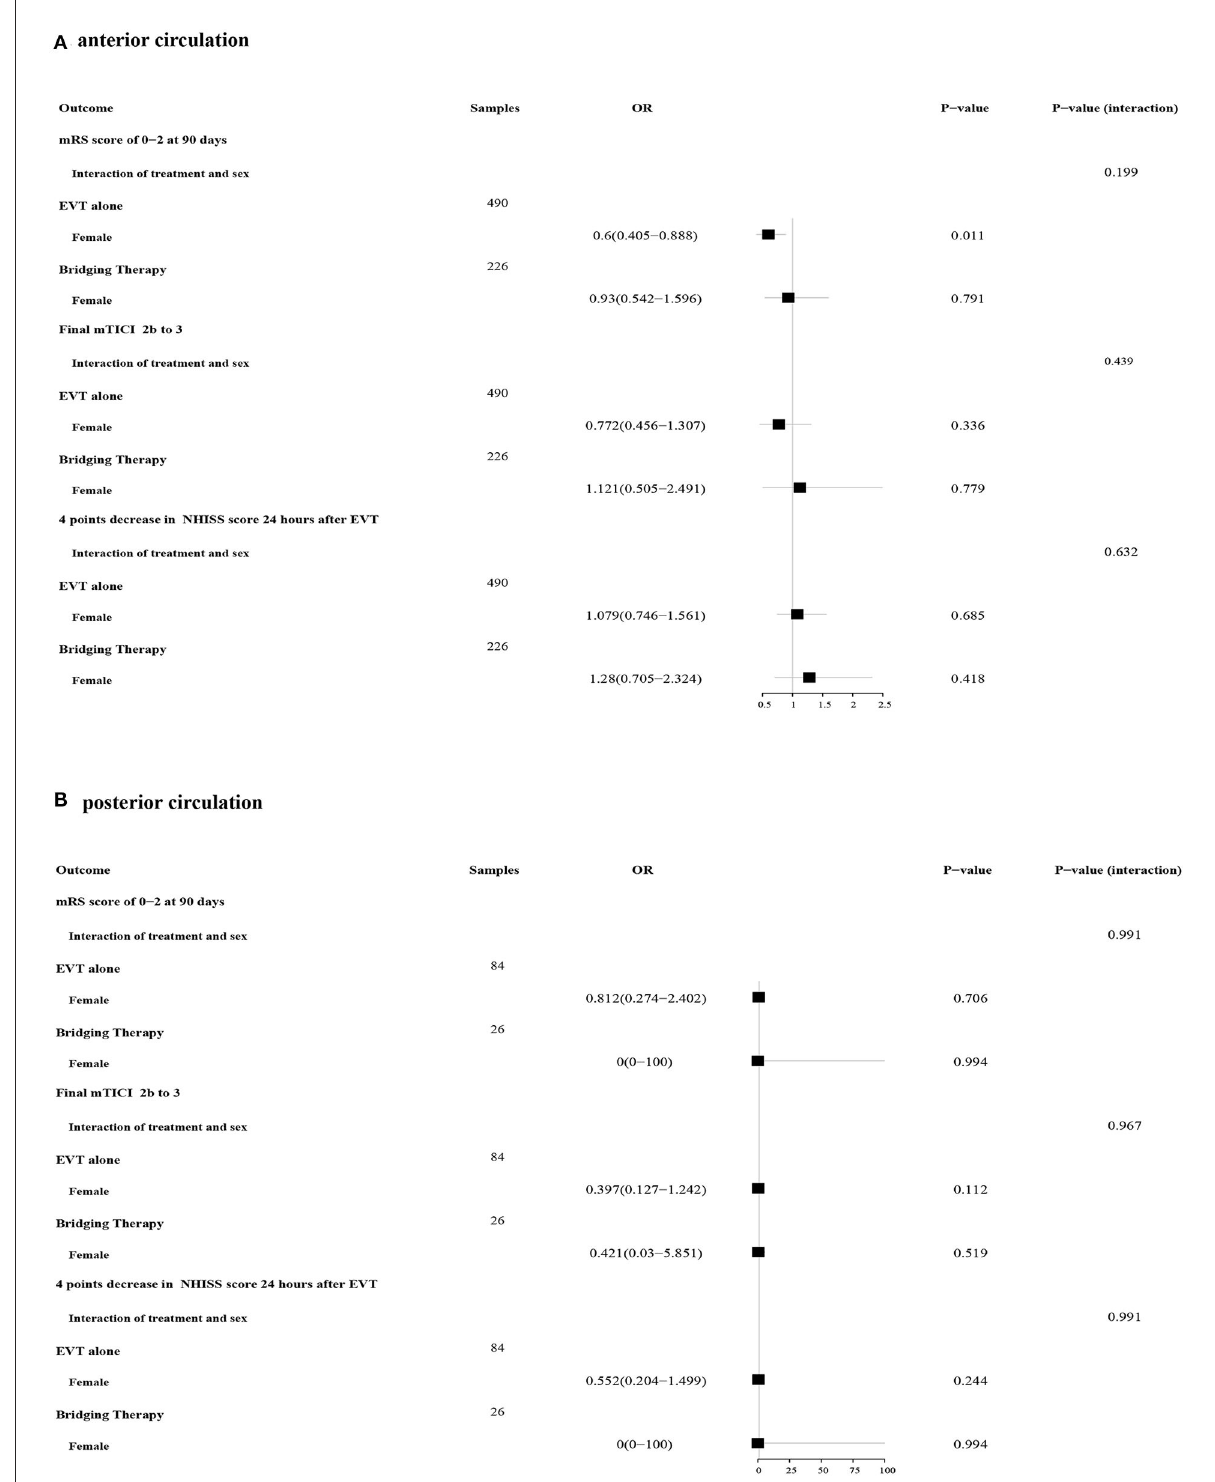
FIGURE3 Forest plots of the association between sex and treatments in primary and secondary outcomes. (A) Forest plots of patients with anterior circulation ischemic stroke; (B) Forest plots of patients with posterior circulation ischemic